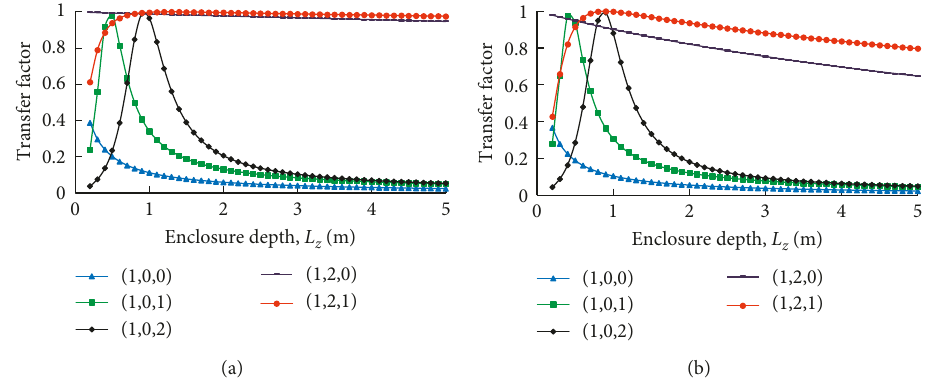
Figure 3: Effect of enclosure depth on the coupling property of the panel-enclosure coupled system with different panel boundary conditions: panel mode (2,3). (a) Simply supported panel mode (2,3). (b) Clamped panel mode (2,3).